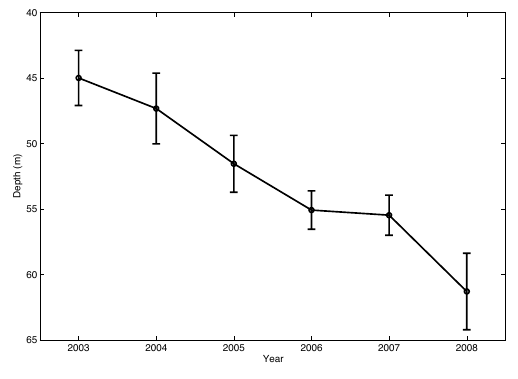
Fig. 12. The average depth (with standard error bars) of the subsur- face chlorophyll maximum in the interior of the Canada Basin from 2003 to 2008. Here, only stations that had a bottom depth greater than 3500m and were along the 140 ◦ W or 150 ◦ W section within the latitudes 73 ◦ –80 ◦ N were used to calculate the average. The number of stations that fit these criteria was 11 in 2003, 12 in 2004, 11 in 2005, 13 in 2006, 15 in 2007, and 14 in 2008.